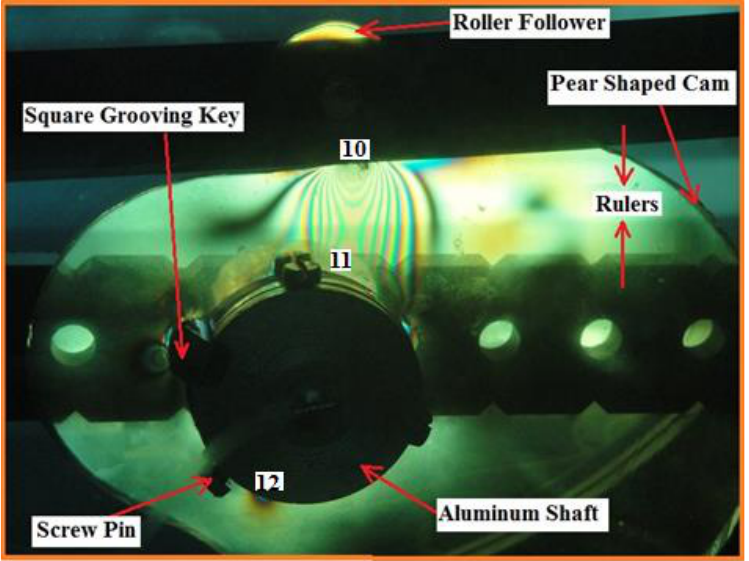
Figure 15. Experimental analysis of the stress distribution when the follower comes in contact with the flank no.(2).